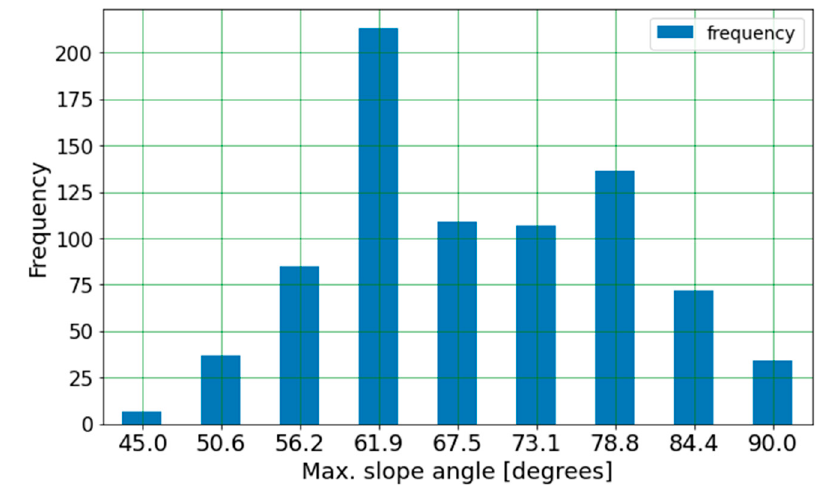
Figure 6. Inclined slope problem geometry.